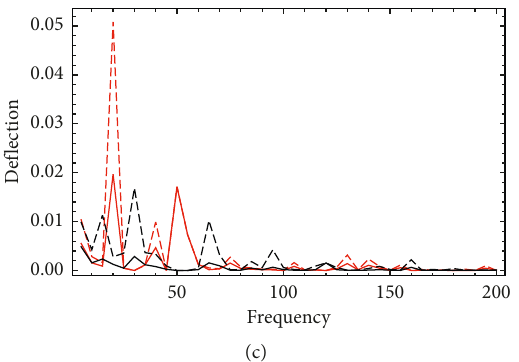
Figure 9: Frequency response: comparison of sparse grids: X GL vs X CC ; maximal transverse deflection w represents the added standard deviation. (a) Gauss X GL p � 2, 41 points. (b) Clenshaw–Curtis X CC p � 2, 41 points. (c) Combined.